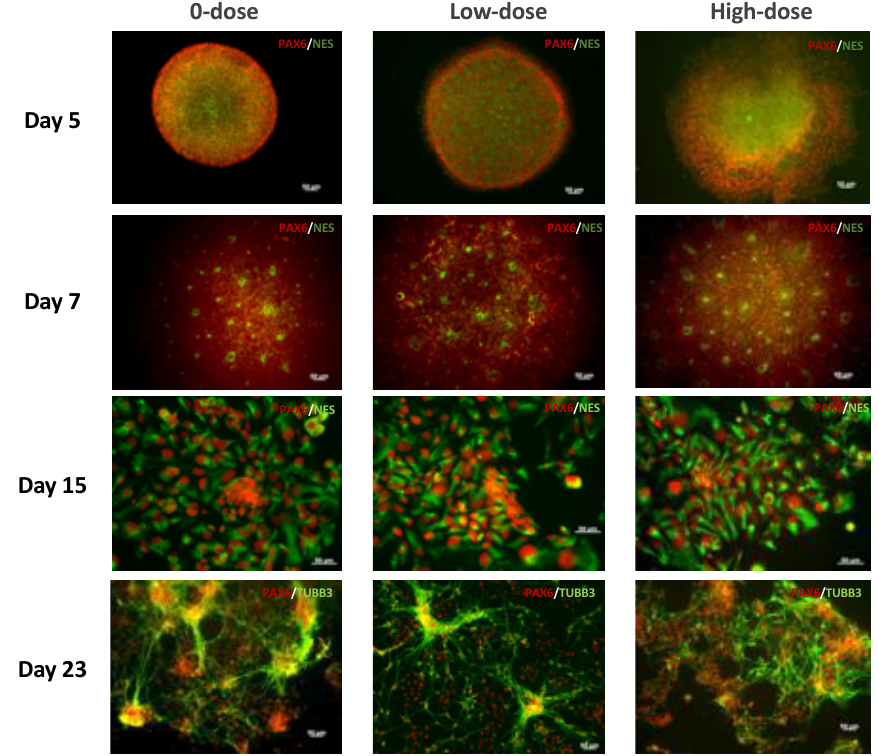
Figure 2. Images of hESCs at different stages of differentiation to neuronal lineage. Staining of embryoid bodies (EBs) (Day 5); neural rosettes (Day 7); human neural progenitor cells (NPCs) (Day 15); and neural precursors (Day 23) with neuronal markers as indicated on the panels. Scale bar = 50 µm.